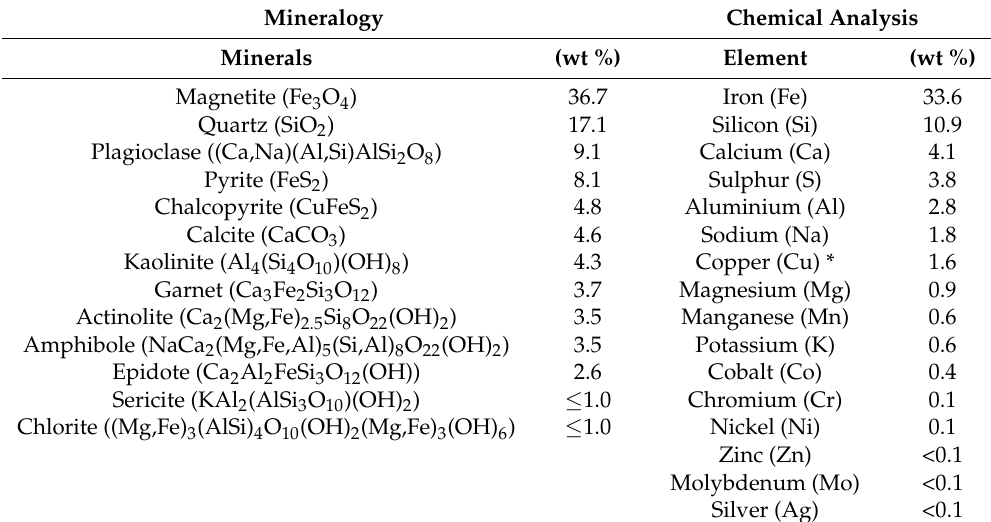
Table 1. Mineralogy and chemical composition of the ore sample.